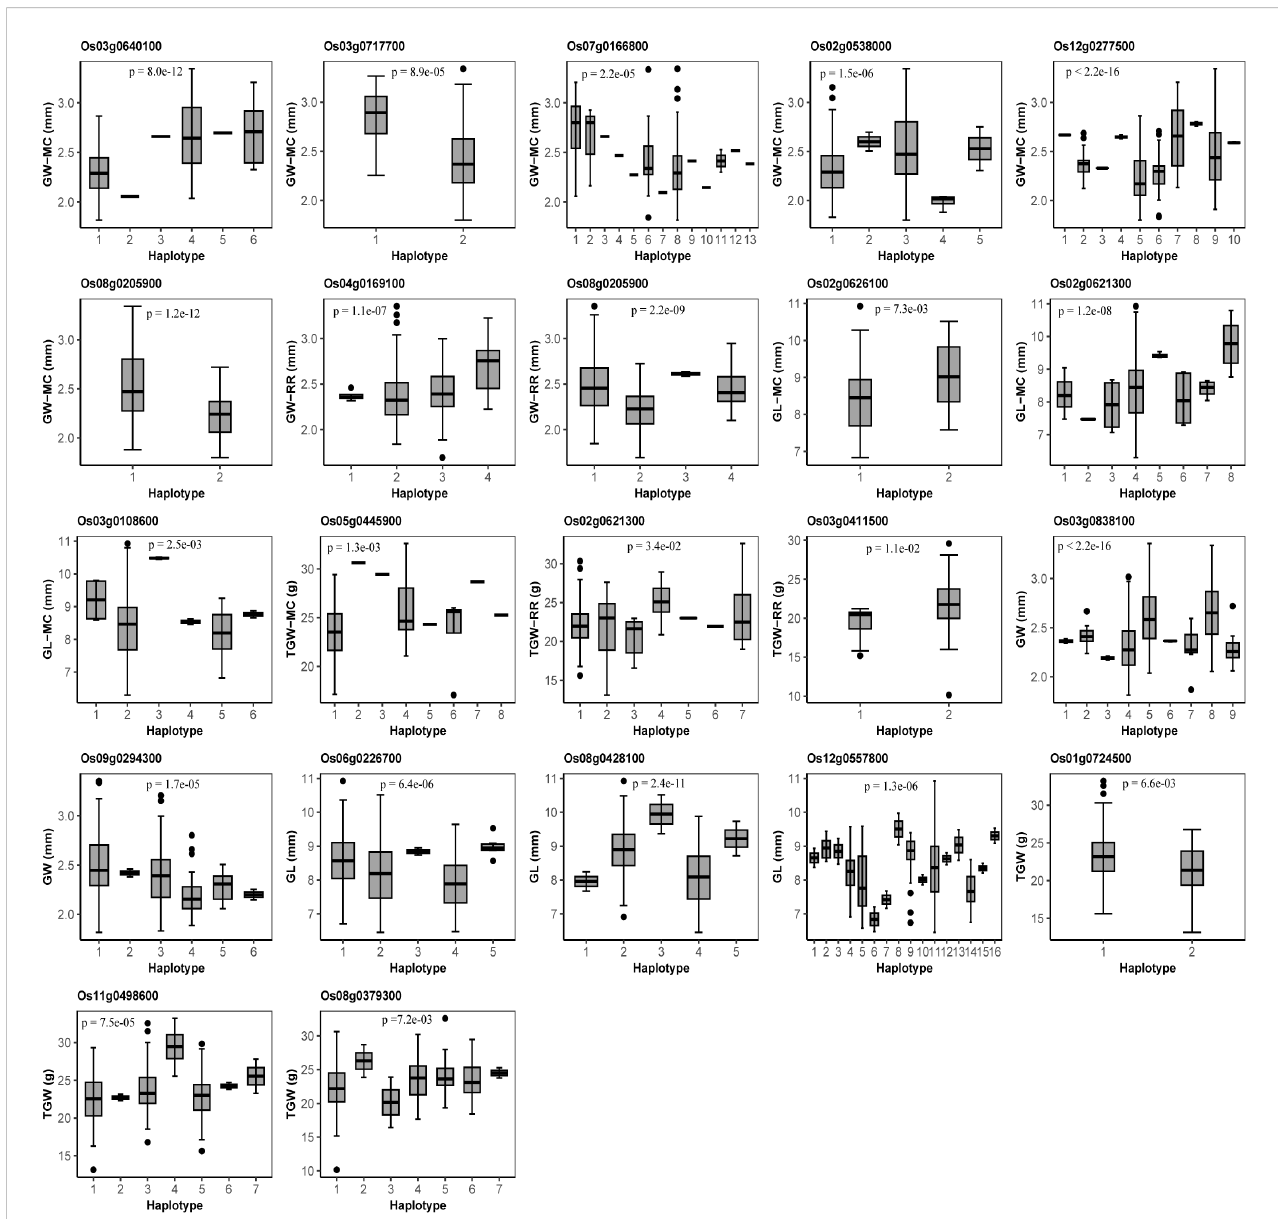
FIGURE 4 Haplotype analysis for candidate genes for grain width (GW), grain length (GL) and thousand grain weight (TGW) in main crop (MC), ratoon rice (RR), and the joint analyses of MC and RR. The P-values indicate the signi fi cance of trait averages across gene haplotypes for GW, GL, and TGW in one-way